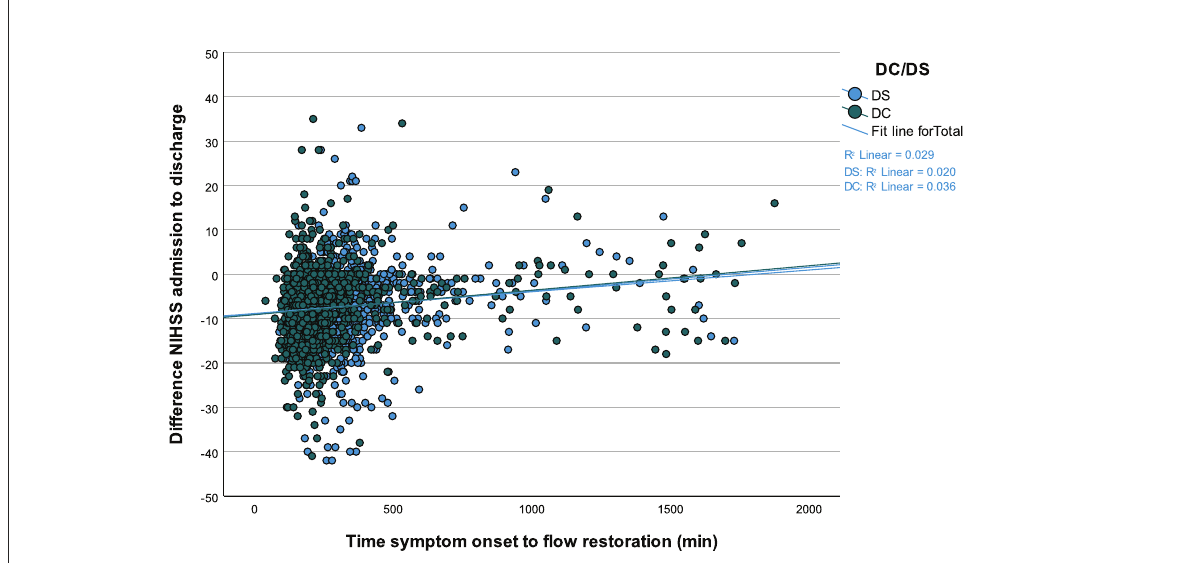
FIGURE3 Correlation between the time from symptom onset to successful endovascular recanalization and the absolute difference of NIHSS scores at hospital admission and discharge. Values < 0 signify a benefit from thrombectomy and values ≥ 0 suggest lack of benefit, which becomes more likely along with passing time in minutes for drip-and-ship (DS) and direct-to-center treated patients ( n = 2,366; ρ = 0.27; p <